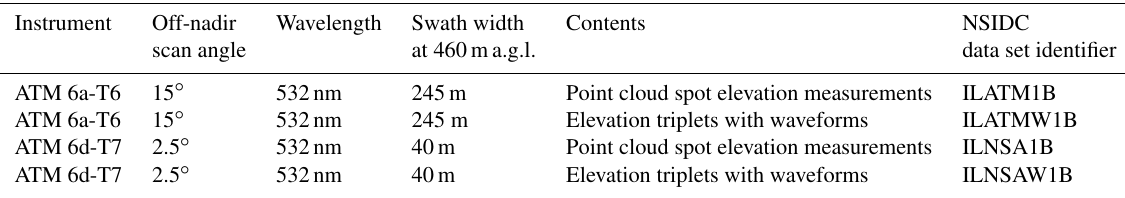
Table 1. Summary of ATM lidar data products used.